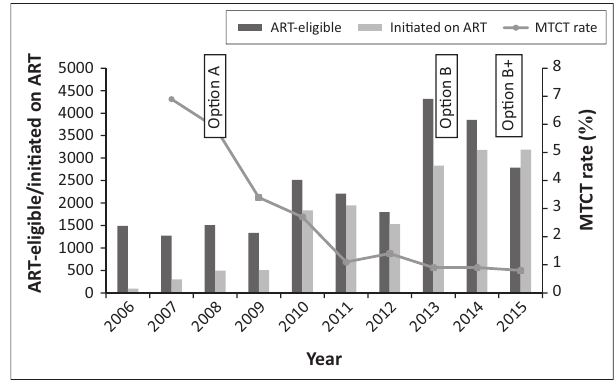
FIGURE 1: Eligible pregnant women initiated on ART and MTCT rate, 2006–2015.